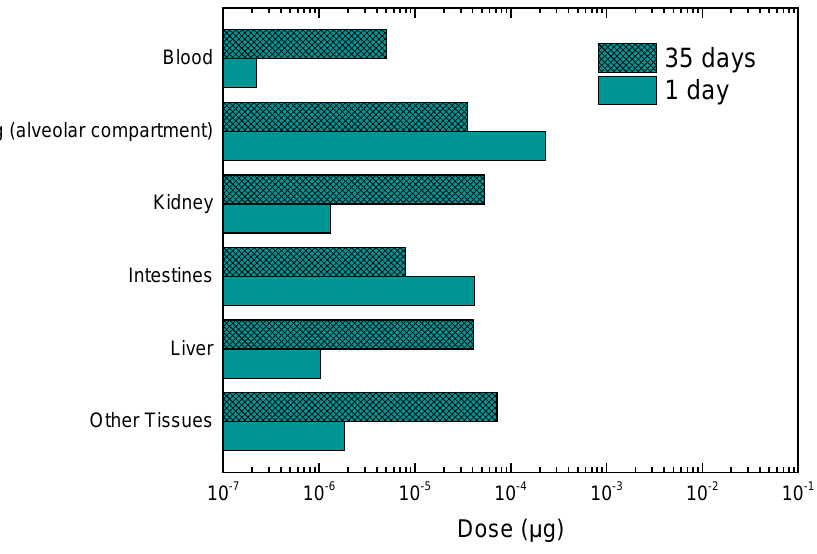
Figure 7. Internal dose (μg) of Cd at different tissues in the human body for an adult male in Kuopio after one day exposure. Also shown the internal dose for one day exposure but after 35 days from initial intake.